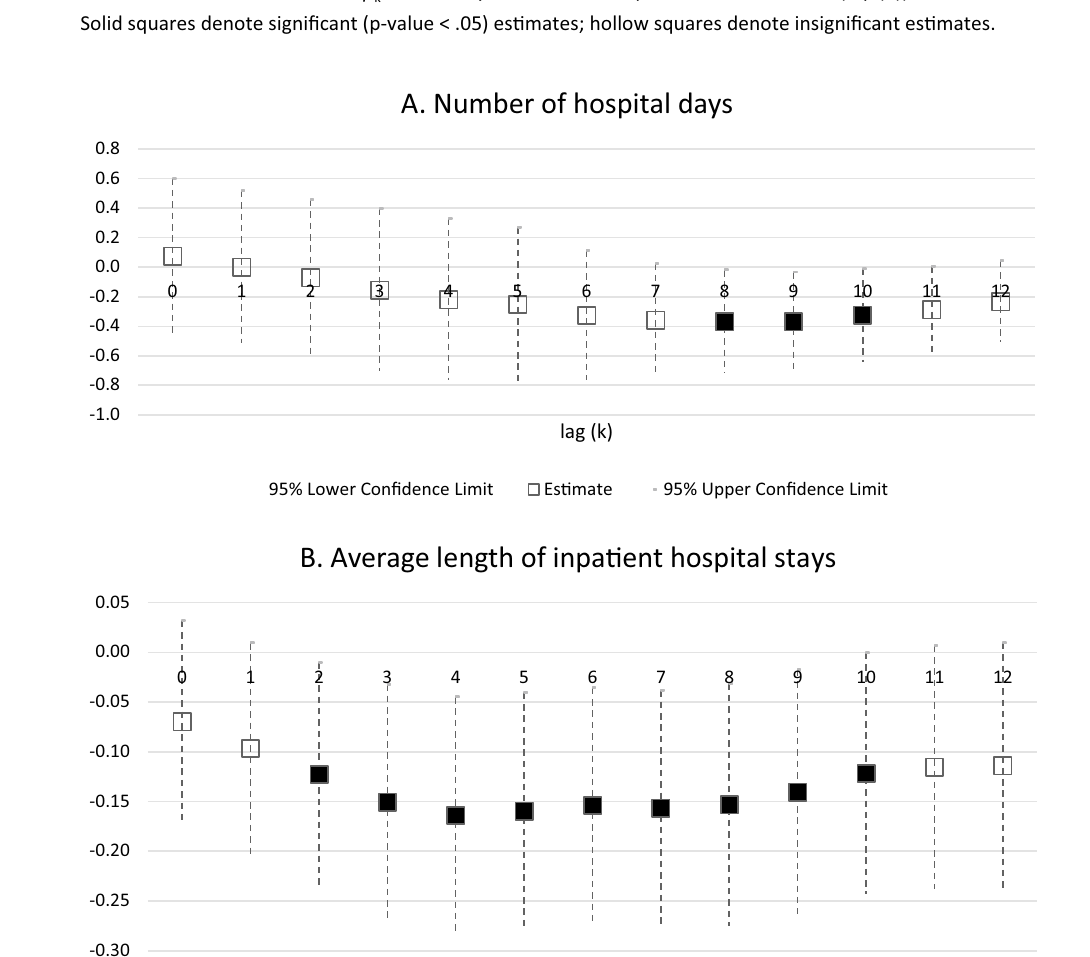
Fig. 5 Estimates of β k from 2-way fixed-effects hospital utilization models [Eq. (3)] Solid squares denote significant ( p value < .05) estimates; hollow squares denote insignificant